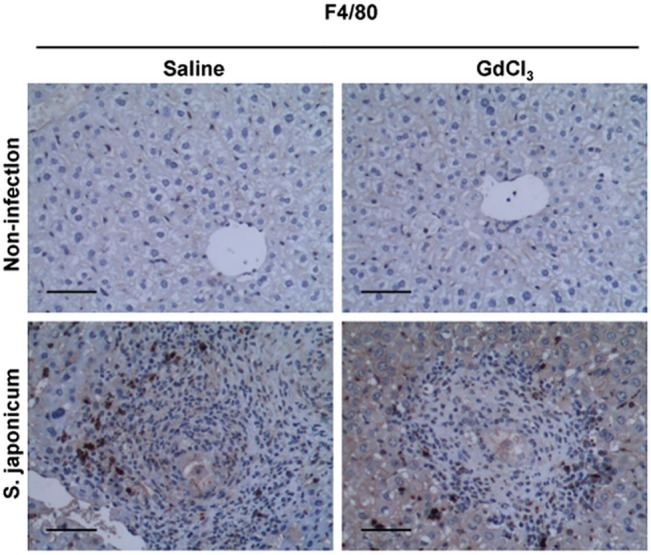
GdCl3 injection reduces F4/80 expression in S. japonicum egg-induced hepatic granuloma.Mice infected with 15 S. japonicum cercariae and treated with GdCl3 (10 mg/kg body weight) or saline twice weekly for 8 times. F4/80 immunohistochemical staining on liver sections prepared from saline-treated mice (control, left column) or GdCl3-treated mice (right column) at day 42 post-infection was shown. Original magnification ×200,bar scale 50 μm. Experiments were repeated at least twice with comparable results.